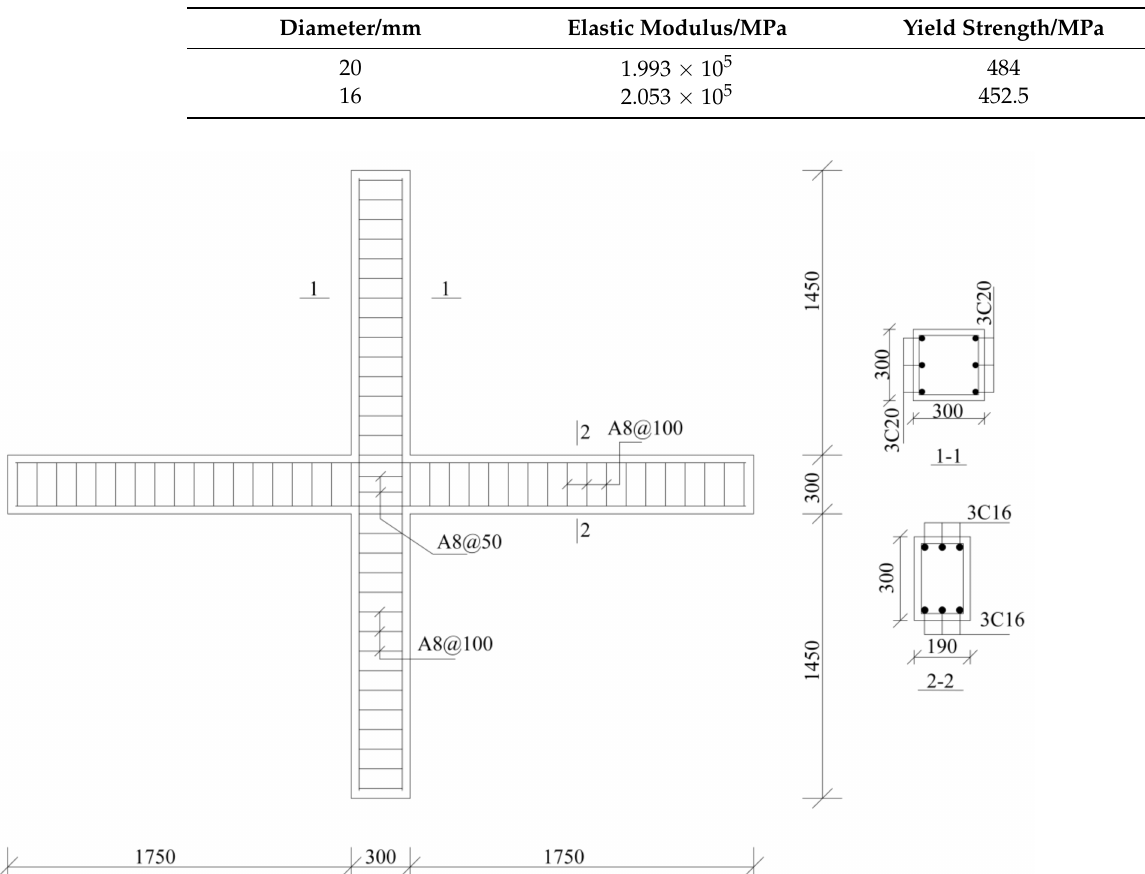
Table 7. Material parameters of rebars.